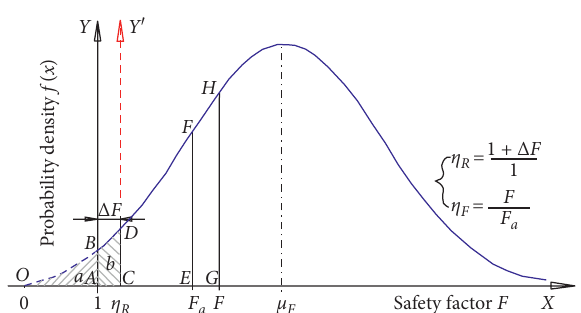
Figure 1: Diagram of η